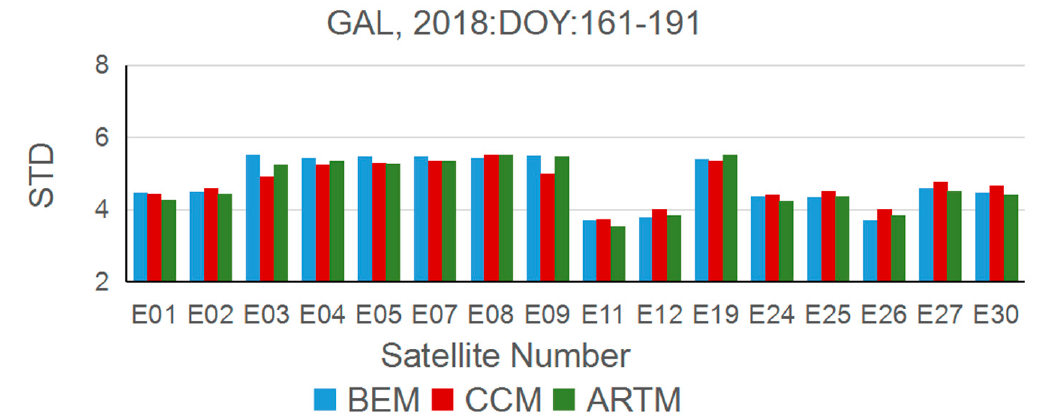
Figure 11. The STD of the satellite repeat shift time for the three methods for each satellite during the period DOY:161–191, 2018.